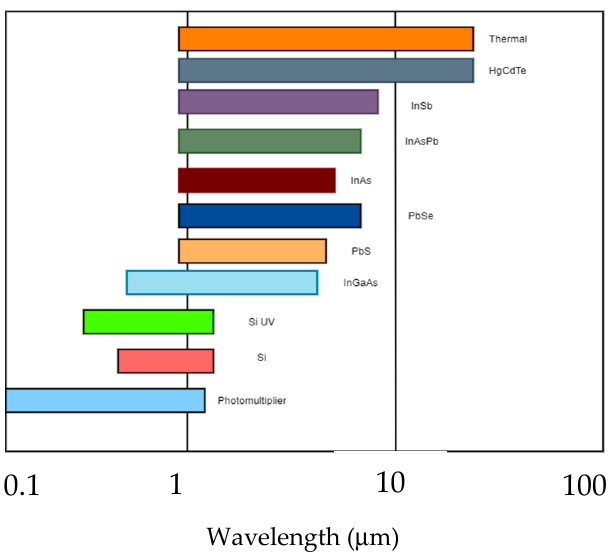
Figure 11. Wavelength sensitivity of common detectors.